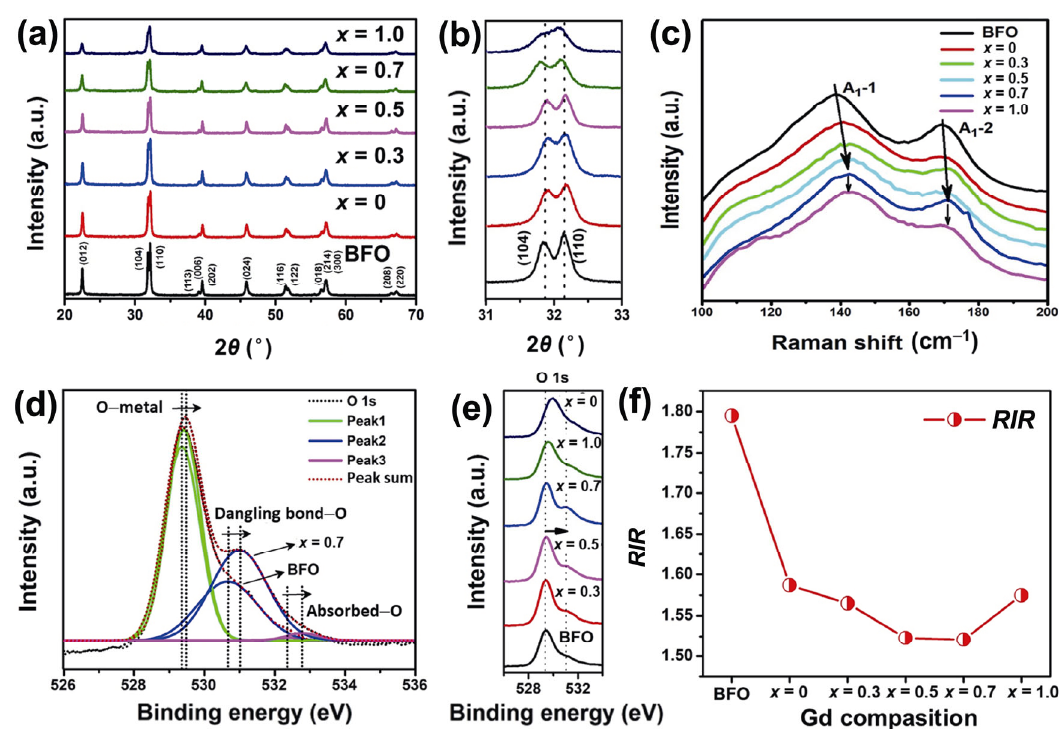
Fig. 2 Crystal structures and chemical structures of BFO and Bi 0.9 (Gd x La 1 − x ) 0.1 FeO 3 ( x = 0, 0.3, 0.5, 0.7, and 1.0): (a) XRD patterns, (b) magnified XRD patterns in the range of 31°–33°, (c) Raman spectra, (d) O 1s XPS spectra of Bi 0.9 Gd 0.07 La 0.03 FeO 3